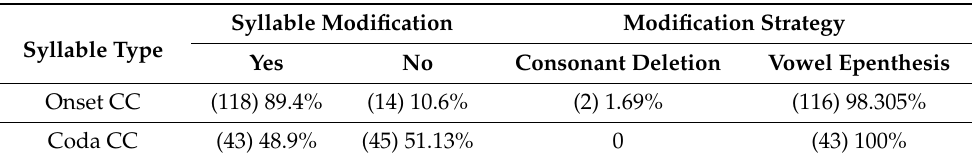
Table 4. Percentage of modification in onset and coda consonant clusters (CC) in FDH’s productions and the modification strategy used.